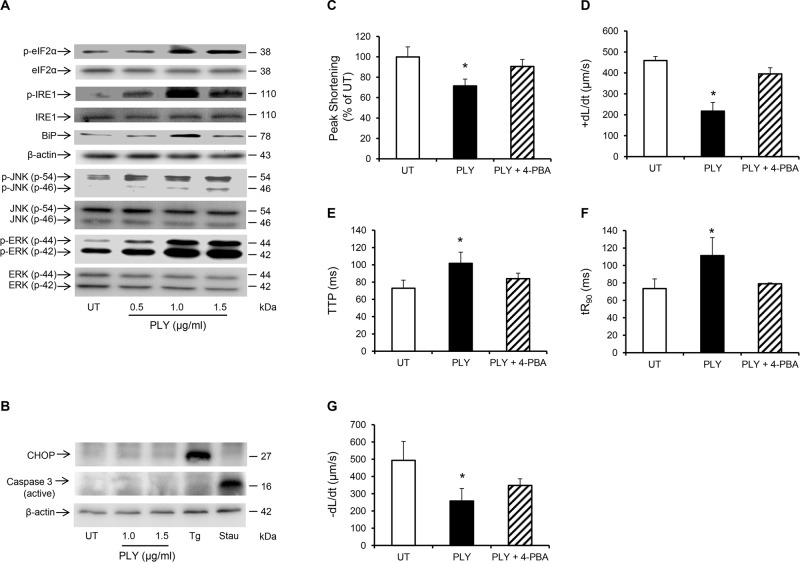
PLY induces endoplasmic reticulum (ER) stress pathway without progressing to apoptosis in HL-1 cardiomyocytes.(A) Typical Western blots showing the activation of ER stress markers, (p-elF2α, p-IRE, BiP), JNK and ERK in HL-1 cells 30 min after PLY treatment. (B) Representative western blots showing the effect of PLY on the induction of apoptotic markers CHOP and active caspase-3 after 8 hour of treatment. Thapsigargin (Tg 5 μM) and Staurosporin (Stau 10 μM) were used as positive inducers of CHOP and active caspase-3 respectively. (C-G) Effects of PLY (1.0 μg/ml) and PLY+ 4-Phenylbutyric acid (4-PBA, an ER stress inhibitor, 10 mM) on Peak Shortening (C), (+dL/dt) (D), TTP (E), tR90 (F) and (-dL/dt) (G) of HL-1 cells after 30 min treatment are presented as Mean±SD (n = 9 from 3 independent experiments). * p<0.05.